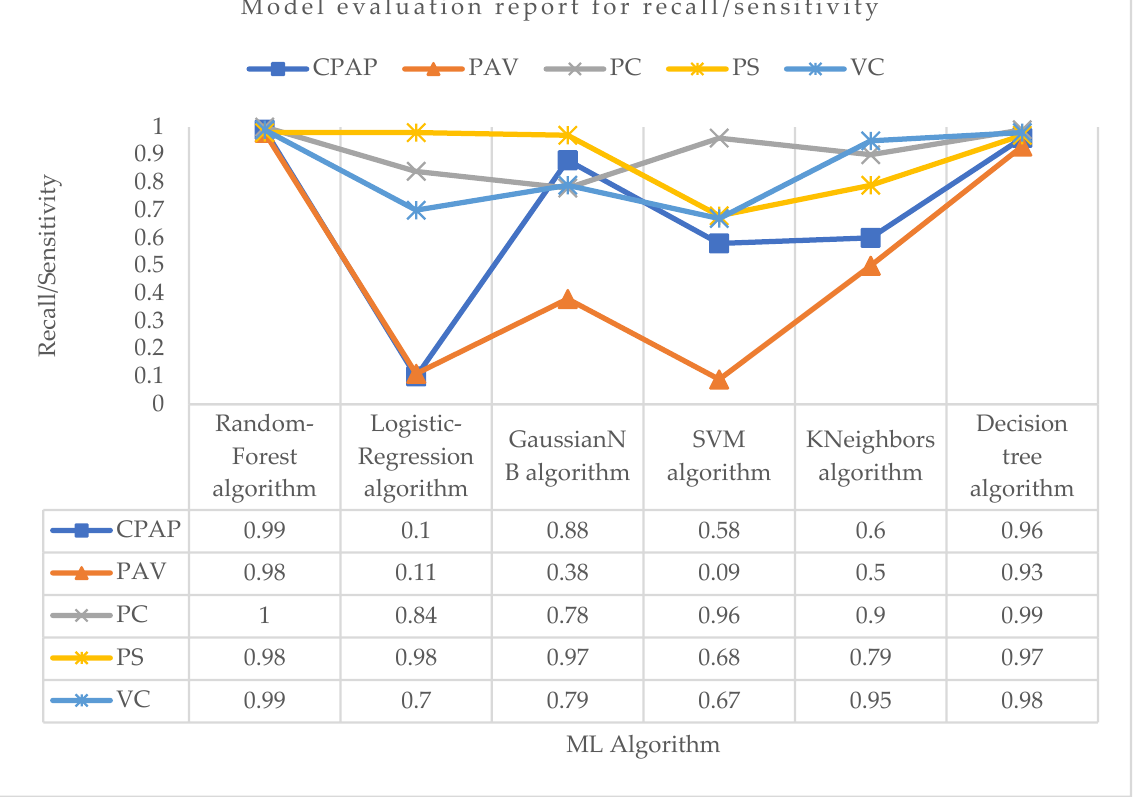
12 of 18 Figure 7. Bar chart visualization of precision comparison among different ML algorithms.